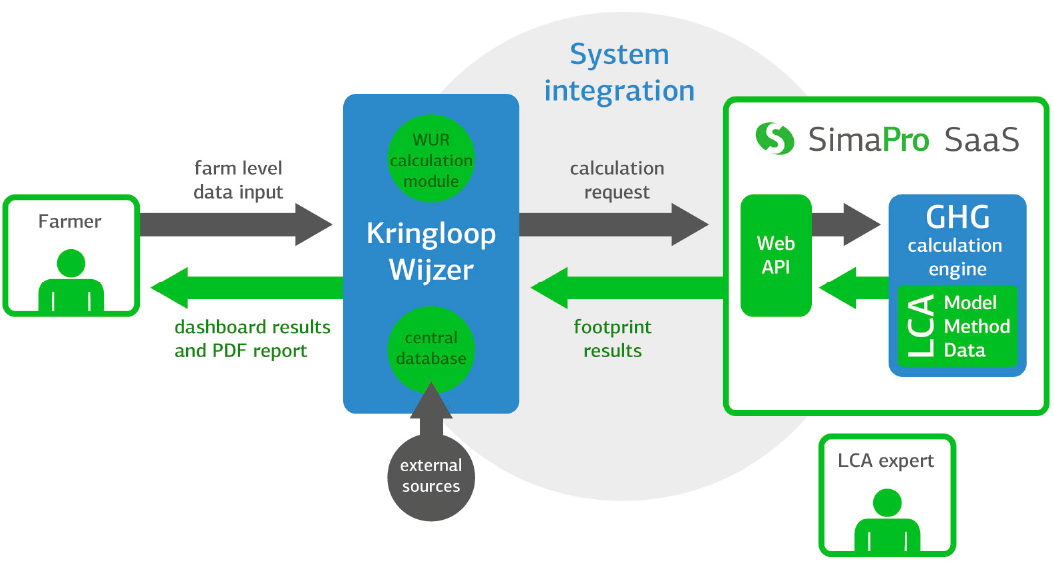
Figure 2. Representation of the solution.